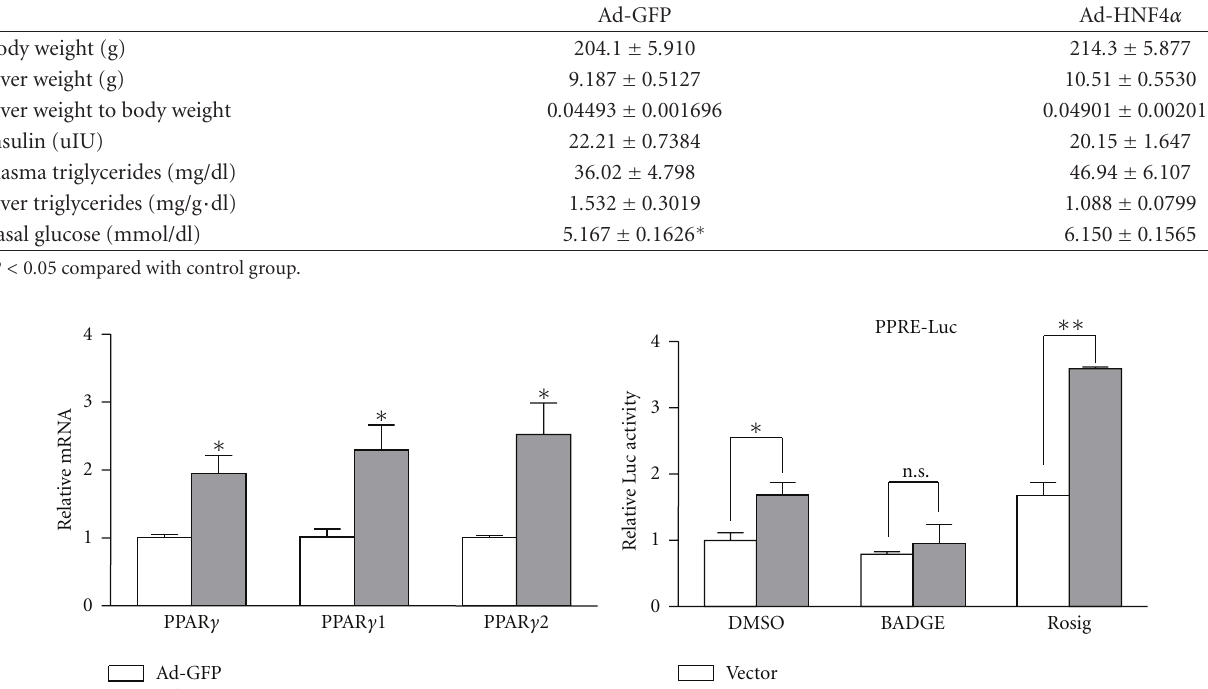
Table 2: Body weight, organ weights, and plasma metabolic values in adenovirus-infected rats.